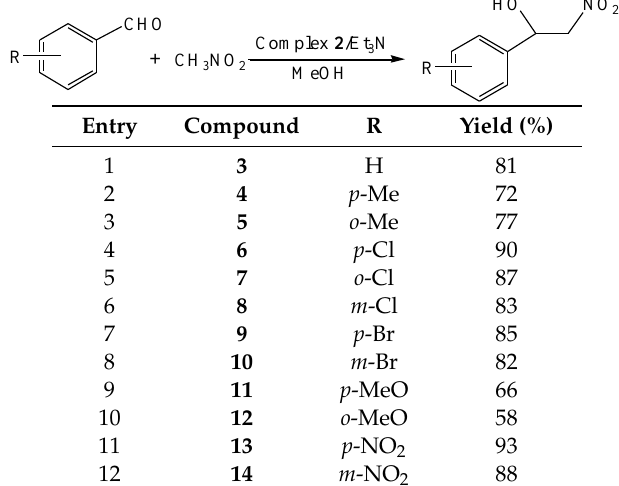
Table 2. Henry reaction of different aromatic aldehydes with nitromethane.